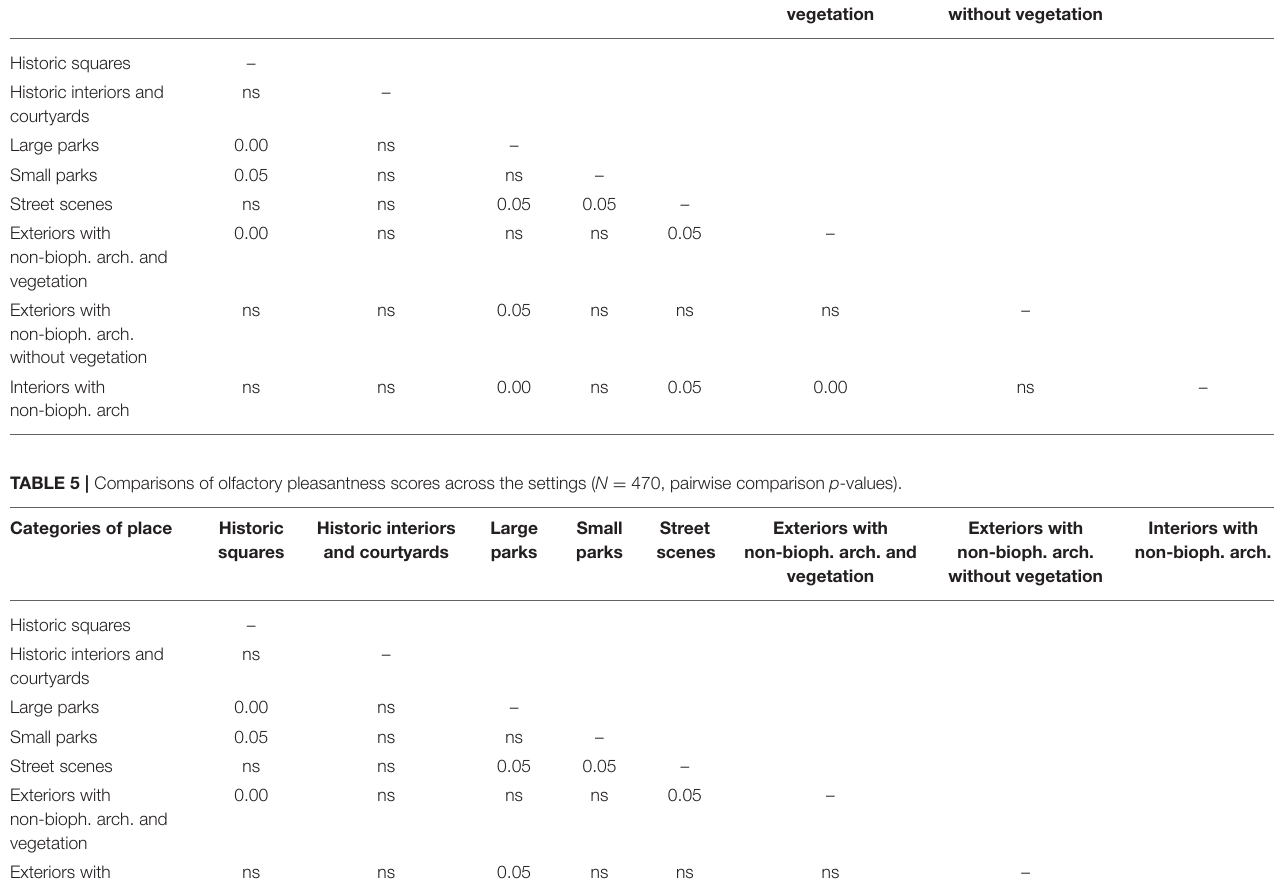
TABLE 4 | Comparisons of the GRP scores across the categories of place ( N = 470, pairwise comparison p -values). Categories of place